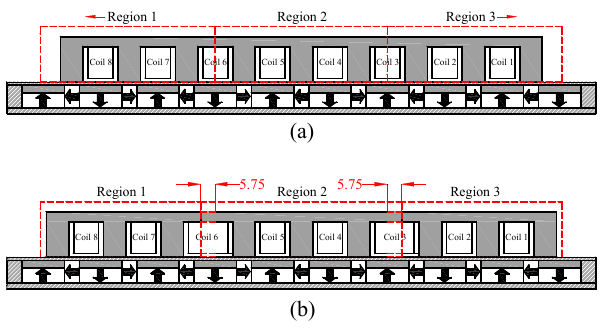
Figure 13. Cross-section of the: ( a ) Optimal 8-slot 8-pole machine; ( b ) proposed machine with teeth arrangement (5.75 mm of shifting length).